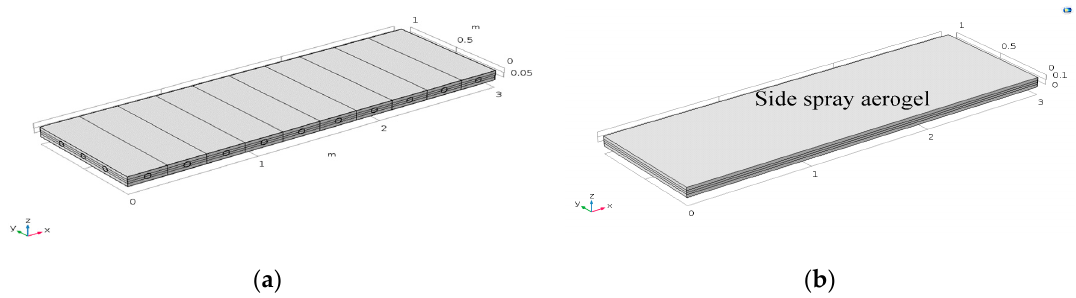
Figure 15. The two forms of heat bridge: ( a ) construction form, and ( b ) aerogel